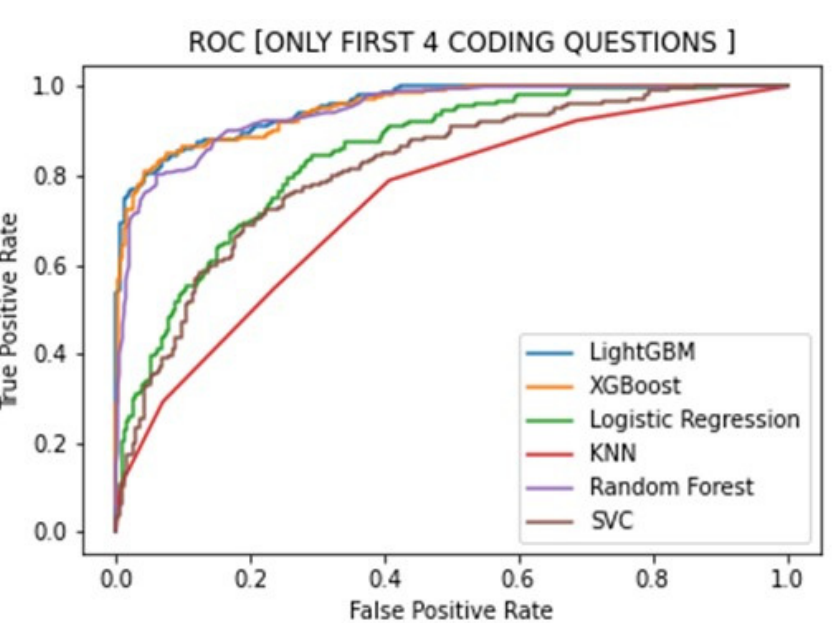
Figure 13. The receiver operating characteristic curve (ROC) for the exam includes the VRL-based questions. Table 5. A detailed description of the used machine learning algorithms and the metrics used to test these models for exams, including the VRL-based questions.